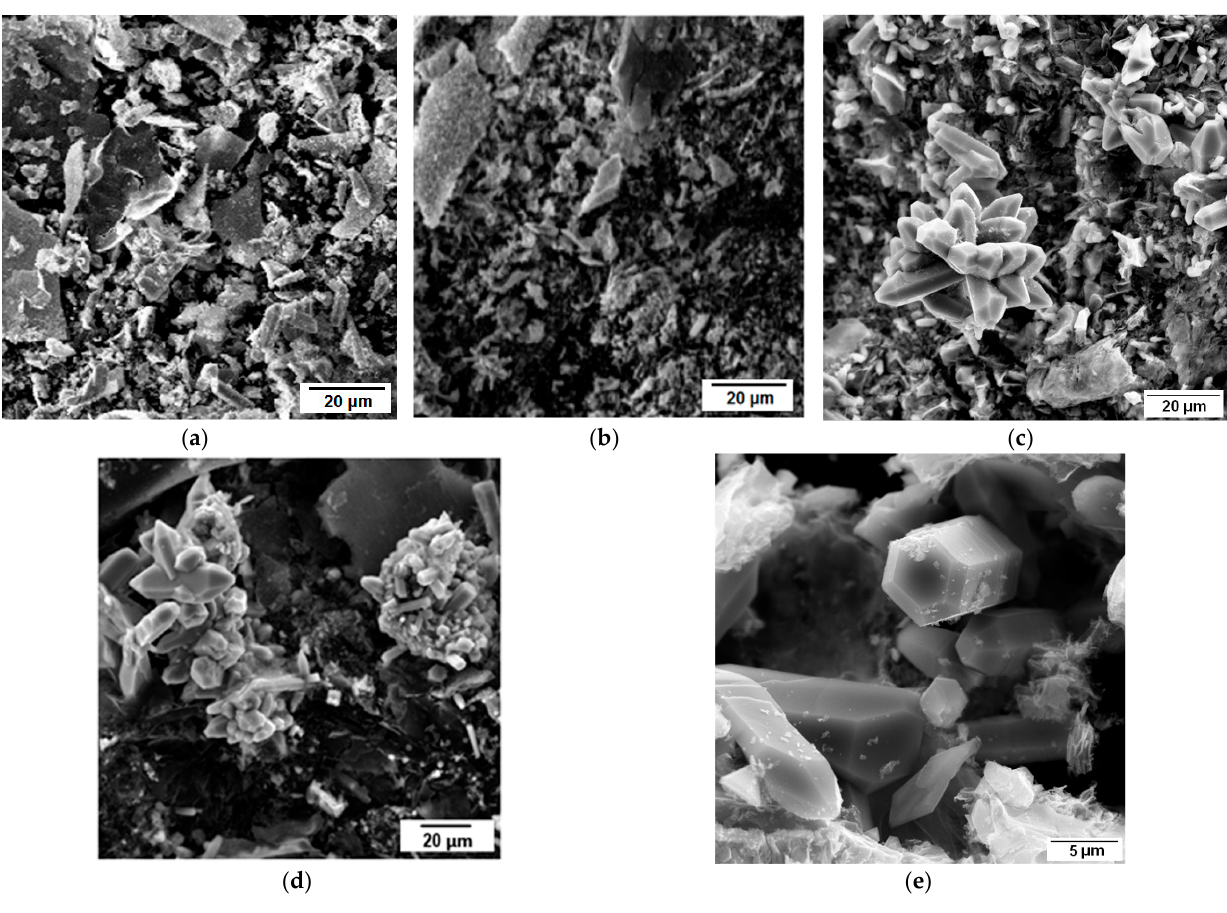
Figure 3. SEM photo of samples 1 ( a ), 2 ( b ) 3 ( c , e ) and 4 ( d